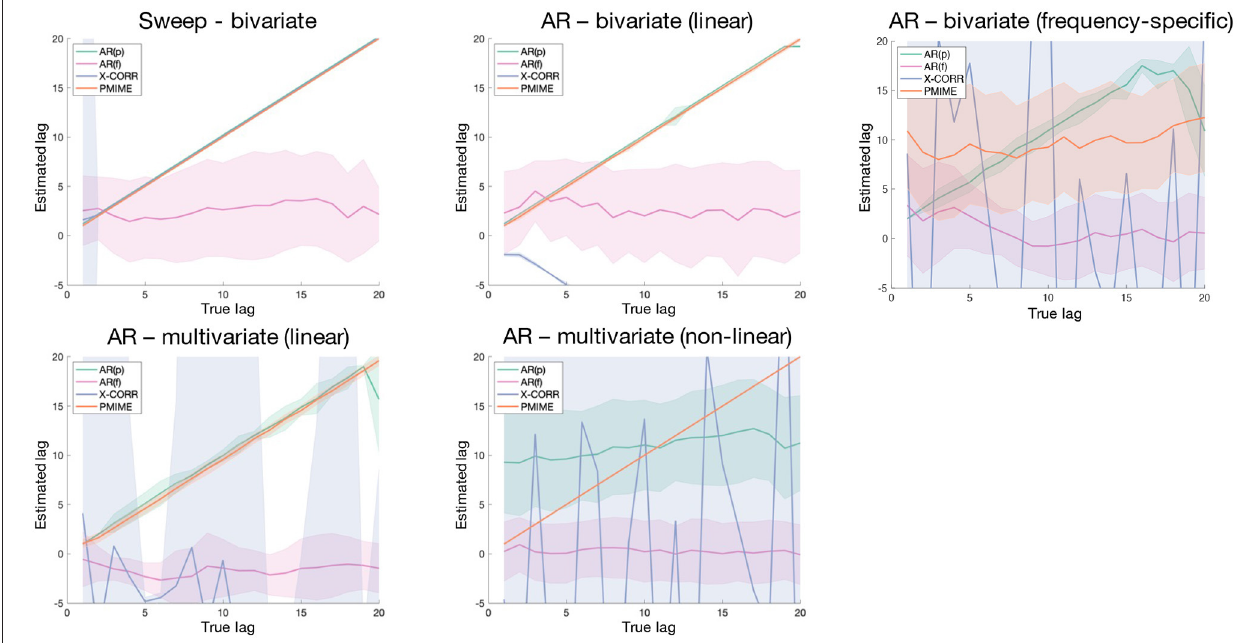
FIGURE 6 | Shaded error bar plots showing the lag estimation in function of the true underlying lag values. The shaded area shows the standard deviation of the estimated lag over 100 realisations of the simulation